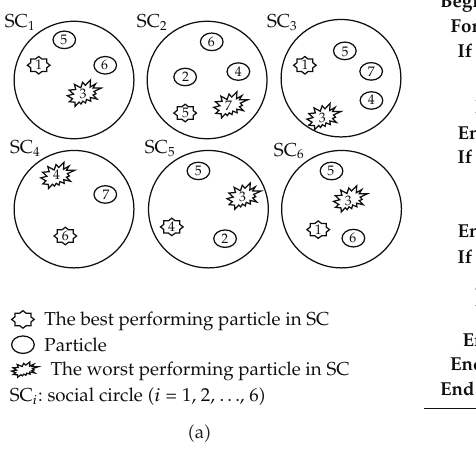
Figure 2: The snapshot of the SCs at iteration t